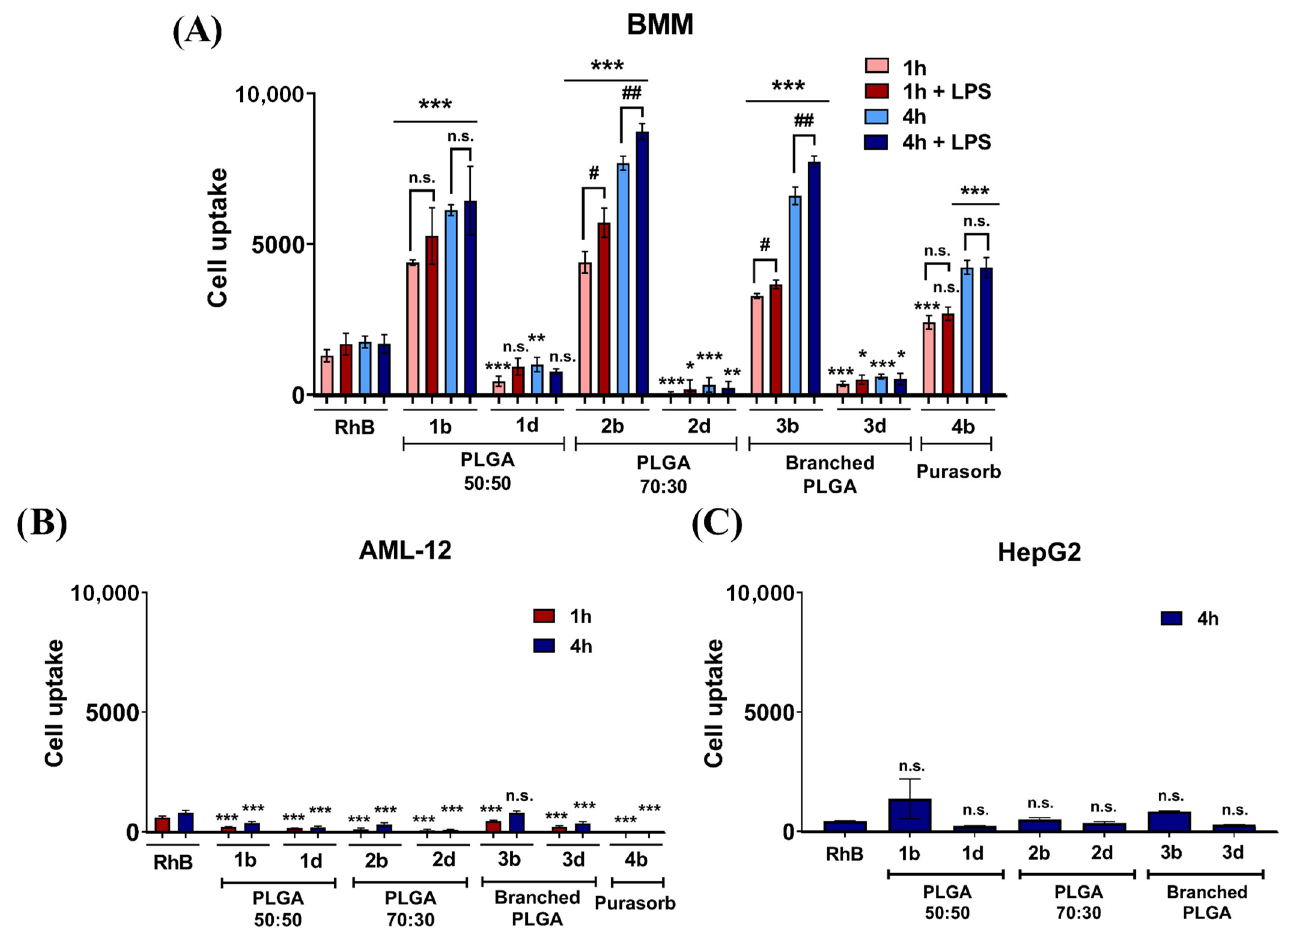
Figure 2. Accumulation of nanospheres in ( A ) Bone marrow-derived macrophages (BMM) either without stimulation or stimulated by lipopolysaccharide (LPS); ( B ) AML-12 cells; and ( C ) HepG2 cells. The accumulation was assessed by measuring the fluorescence of nanosphere-incorporated Rhodamine B (RhB) after 1 and 4 h of incubation. The terms 1b, 1d, etc. refer to the formulations presented in Tables 1 and 2 and refer to the use of the nanoprecipitation method (NPM) for the b-indexed formulations, and of the emulsification solvent evaporation method (ESE) for the d-indexed formulations, respectively. The values were weighted taking into account the loading efficiency of the individual formulations. The results are compared to a solution of free RhB in concentration 15 µg/mL. * p < 0.05, ** p < 0.01, *** p < 0.001, statistically significant difference of cell entry rate in comparison to RhB solution; # p < 0.05, ## p < 0.015 statistically significant effect of BMM stimulation on a nanosphere cell uptake.